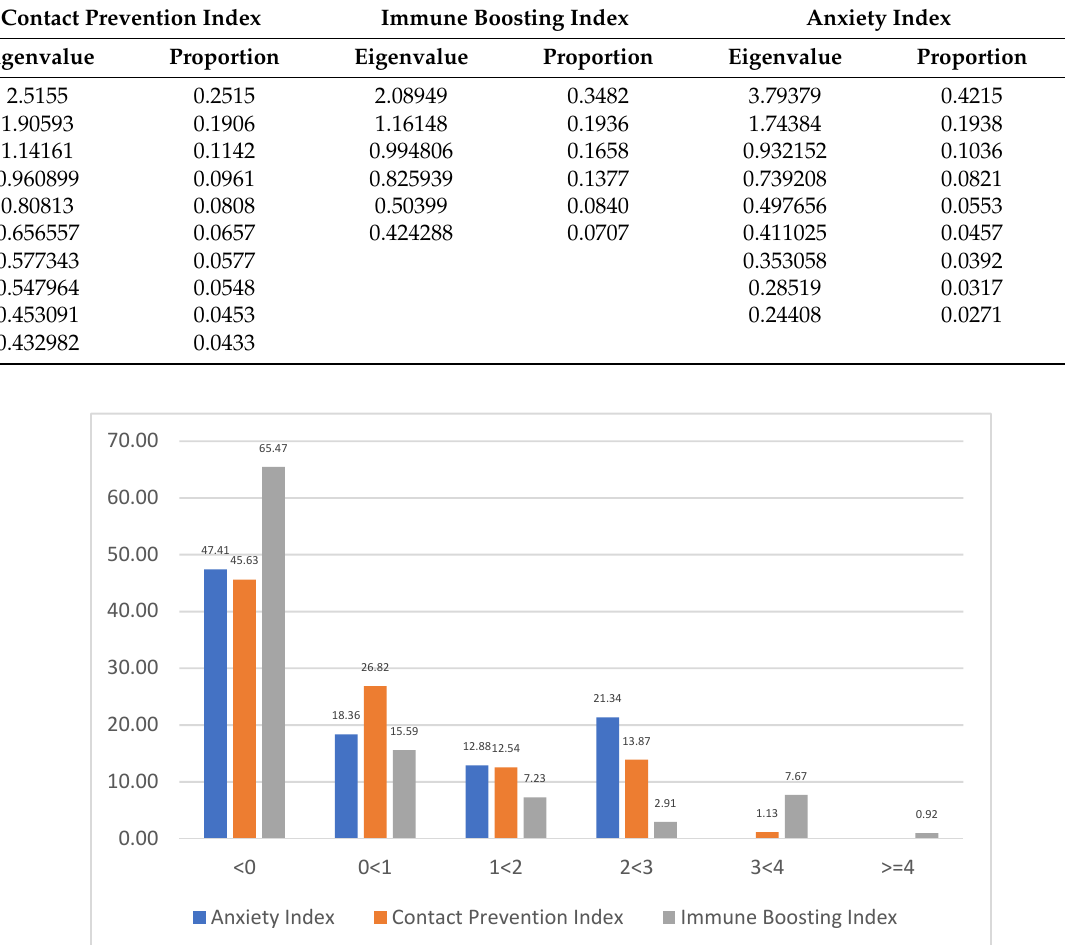
Table 2. Eigenvalues and contributions of each component to estimated parameter.